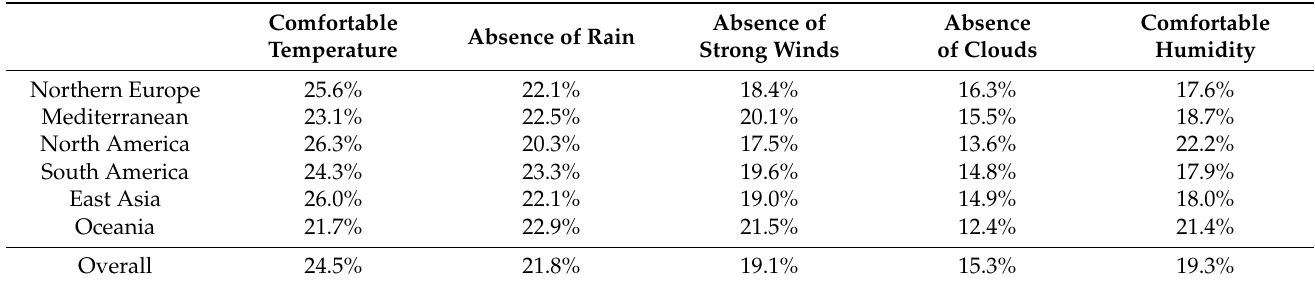
Table 4. Weights of climate variable by nationality group in the context of urban tourism derived from the present survey.